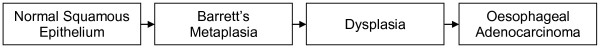
The Barrett's metaplasia-dysplasia-adenocarcinoma sequence.